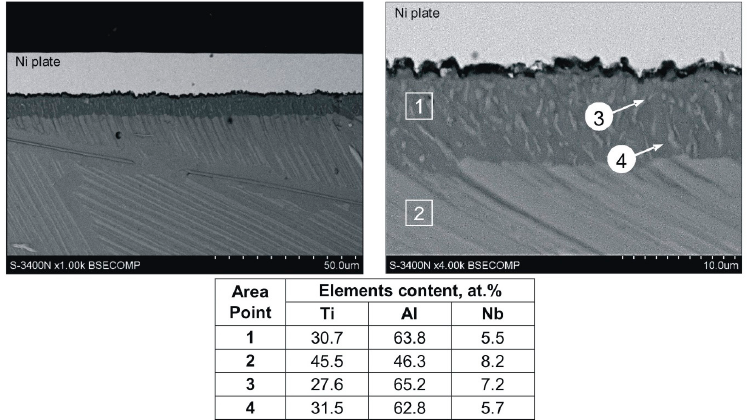
Figure 6. The microstructure (SEM) and chemical composition of the marked areas (points 1–4) in the diffusion aluminide coating on Ti–45Al–8Nb–0.5(B, C) alloy obtained using vapor aluminizing.